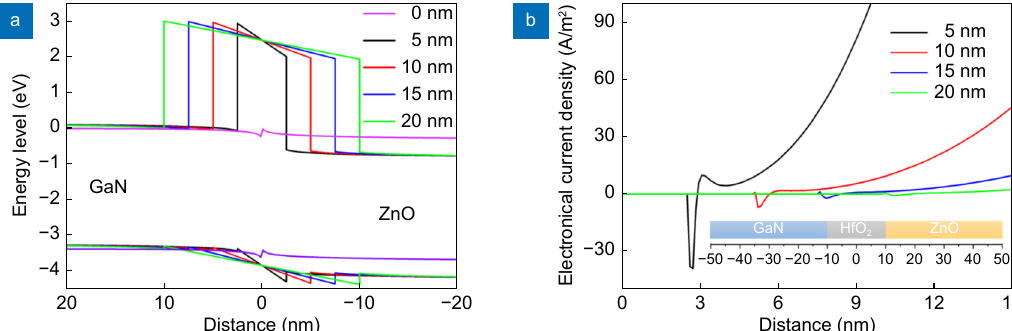
Fig. 7 | ( a ) Energy band of ZnO/HfO 2 /GaN LEDs based on theoretical simulation. ( b ) The distribution of electronical current density in ZnO/HfO 2 /GaN LEDs. The inset picture displays a structure diagram of simulation.